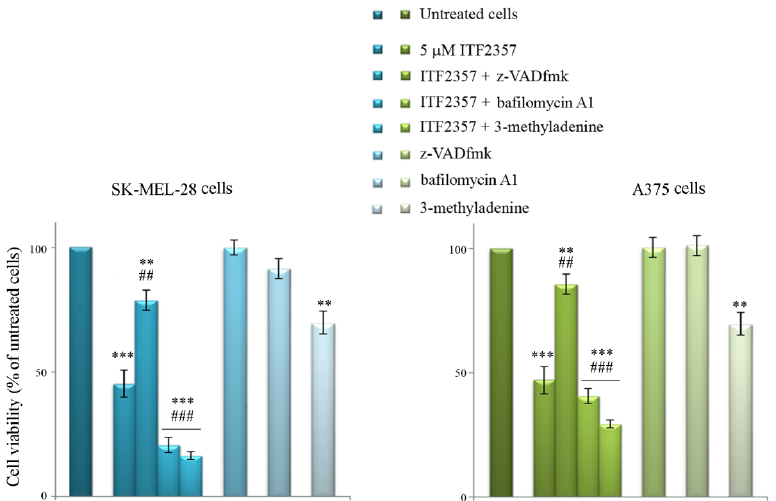
Figure 8. The influence of autophagy inhibitors and pan-caspase inhibitors on the effects of ITF2357. SK-MEL28 and A375 cells were pre-treated for two hours with the autophagy inhibitors bafilomycin A1 (20 nM) or 2.5 mM 3-methyladenine (2.5 mM), then 5 µM ITF2357 was added, and the incubation was protracted for 48 h. Co-treatment ITF2357 with the caspase inhibitor z-VADfmk (80 µM) was maintained for 48 h. MTT assay was performed as indicated in Materials and Methods to evaluate cell viability. The results reported in the histograms are representative of three independent experiments. ** p < 0.01, *** p < 0.001 with respect to untreated cells; ## p < 0.01, ### p < 0.001 with respect to ITF2357 treated cells. The same figure shows the effects of the general caspase inhibitor z-VADfmk, which almost completely prevented the effect of ITF2357. This result supports that caspa-